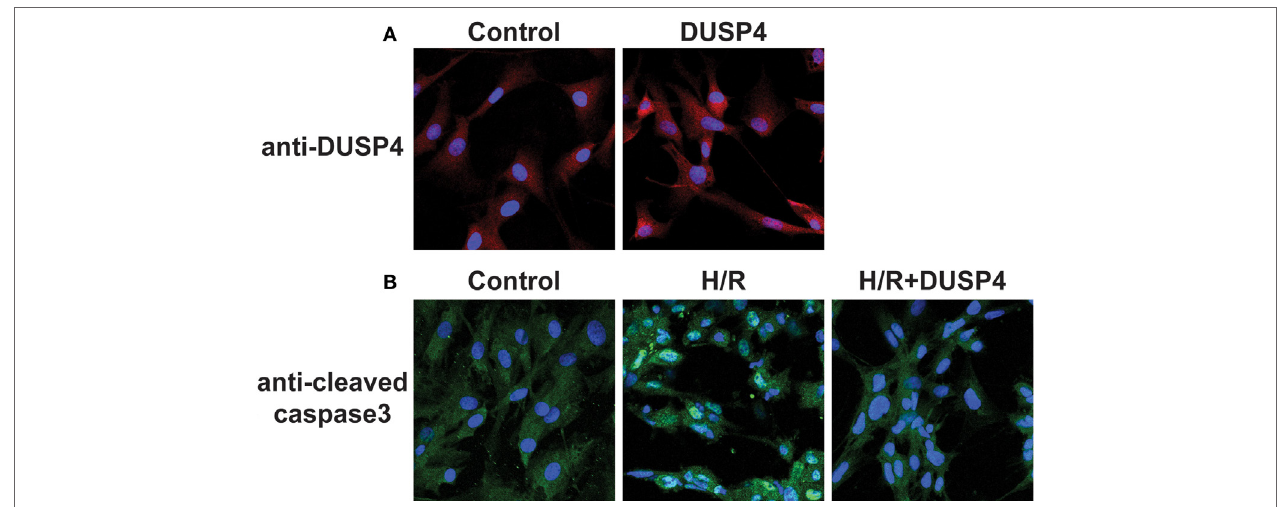
FigUre 1 | Dual-specificity phosphatase 4 (DUsP4) overexpression in endothelial cells prevents h/r-induced apoptosis . (a) Bovine aortic endothelial cells (BAECs) immunostaining against DUSP4 (red) and DAPI (blue) staining for nuclei. The population of BAECs overexpressed DUSP4 is 72.67 ± 5.53%, as determined by immunostaining with DUSP4 antibody. The level of DUSP4 overexpression in BAECs is increased by 1.28 ± 0.02-fold compared to control cells ( P < 0.05, n = 3). The result indicated that DUSP4 is overexpressed 72 h post-transfection. (B) BAECs immunostaining against cleaved caspase-3 (green) and DAPI (blue) staining for nuclei. Under H/R stress, the percentage of apoptotic cells is increased by 41.08 ± 9.87% compared to the control and DUSP4 H/R groups ( P < 0.05, n ≥ 3). Overexpression of DUSP4 decreases H/R-induced cleaved caspase-3 activation to the similar level of the control and prevents apoptosis ( n ≥